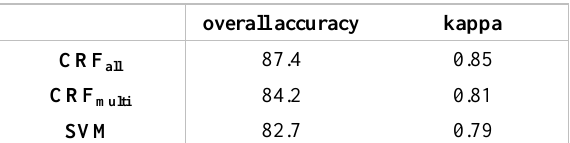
Table 4. Overview on overall accuracy and kappa